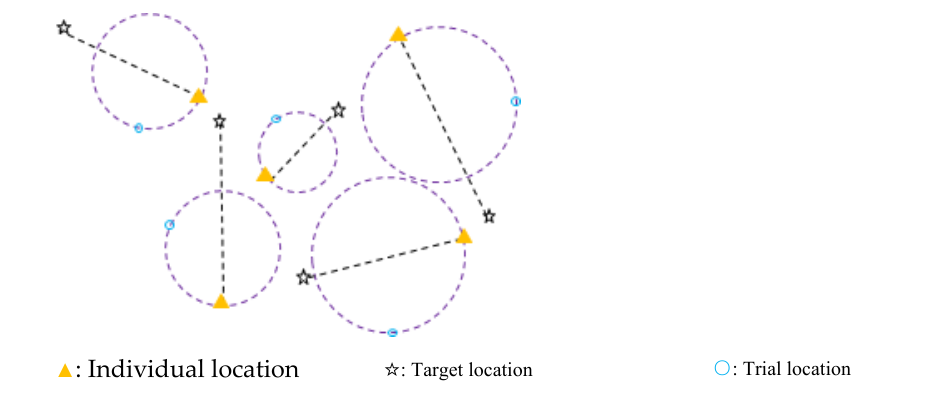
Figure 1. Demonstrating the spherical (circular) boundary of the SS in a two-dimensional search space.